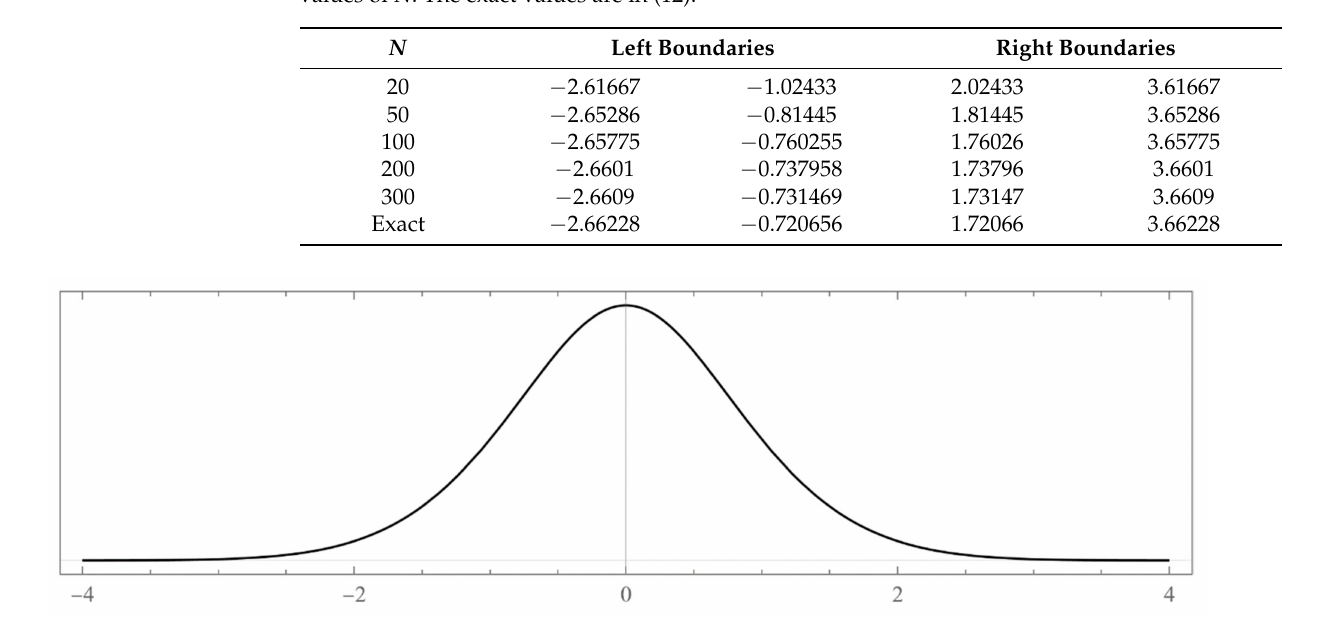
Figure A13. The un-normalized wavefunction (cid:101) ψ ( x , E ) for the bound state inside the energy gap with E = 3 λ 2 /2. The horizontal x -axis is in units of λ − 1 . We took N = 100.